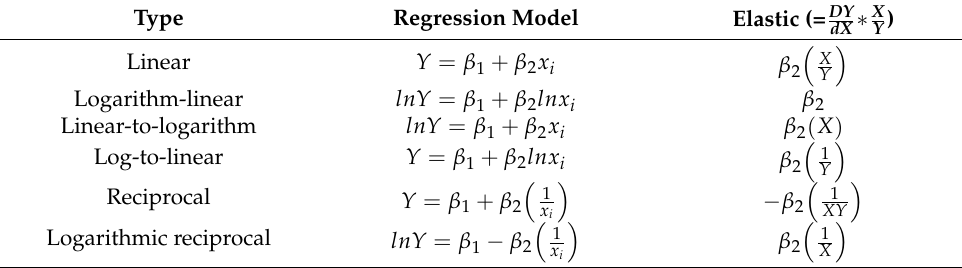
Table 3. Regression model and regression